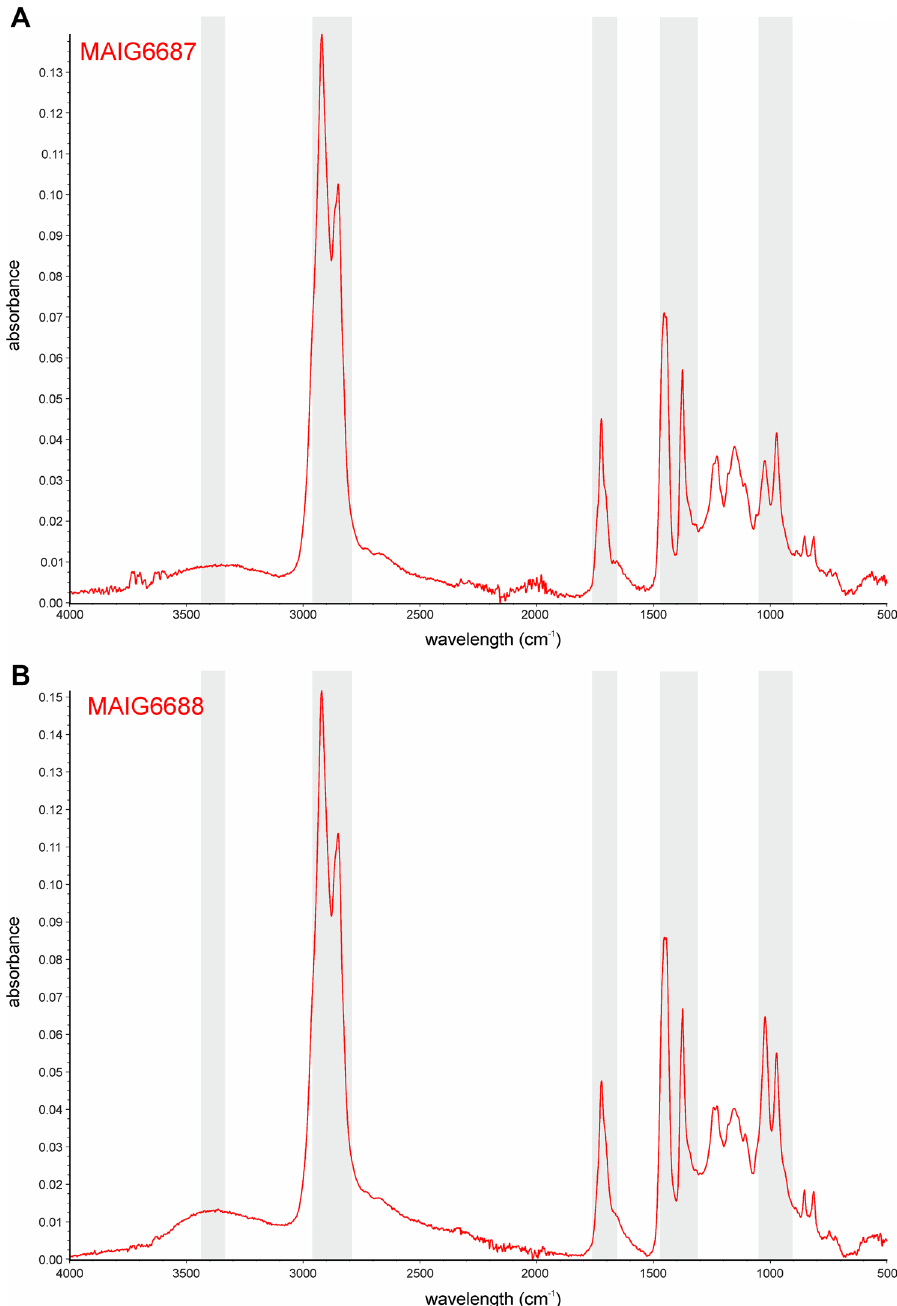
Figure 6. FT-IR spectra of the amber pieces. ( A ) Piece with inclusion of Megalophthallidion burmapteron gen. et sp. nov., holotype MAIG6687 and ( B ) Piece with inclusion of Megalophthallidion sp. nymph